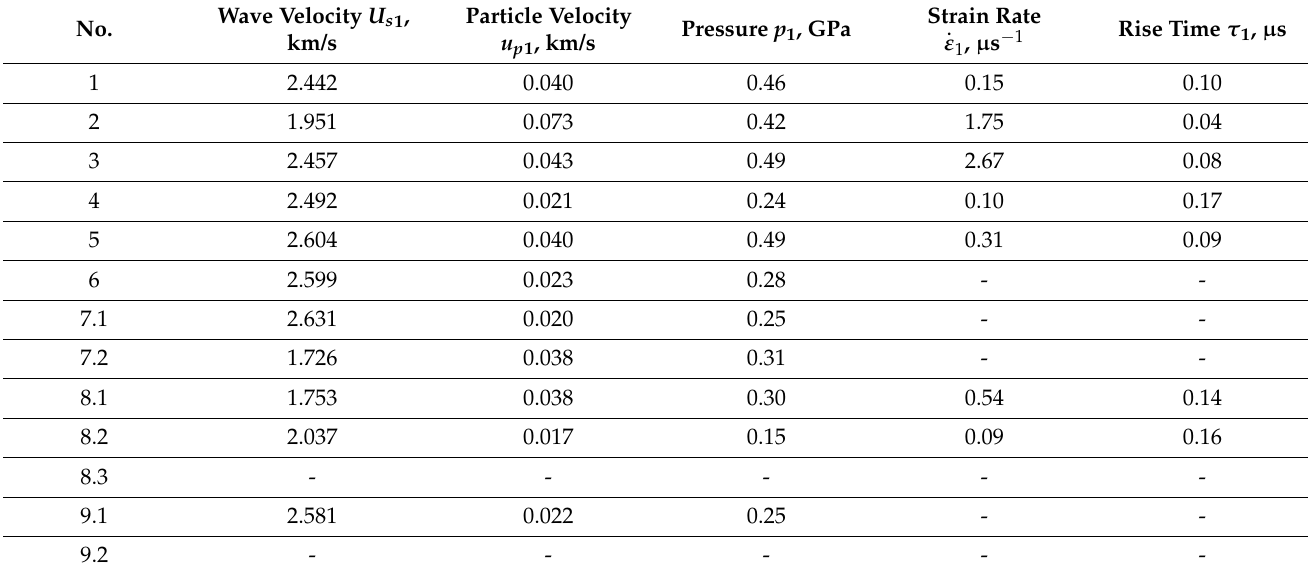
Table 2. Hugoniot and wave front data for precursor.